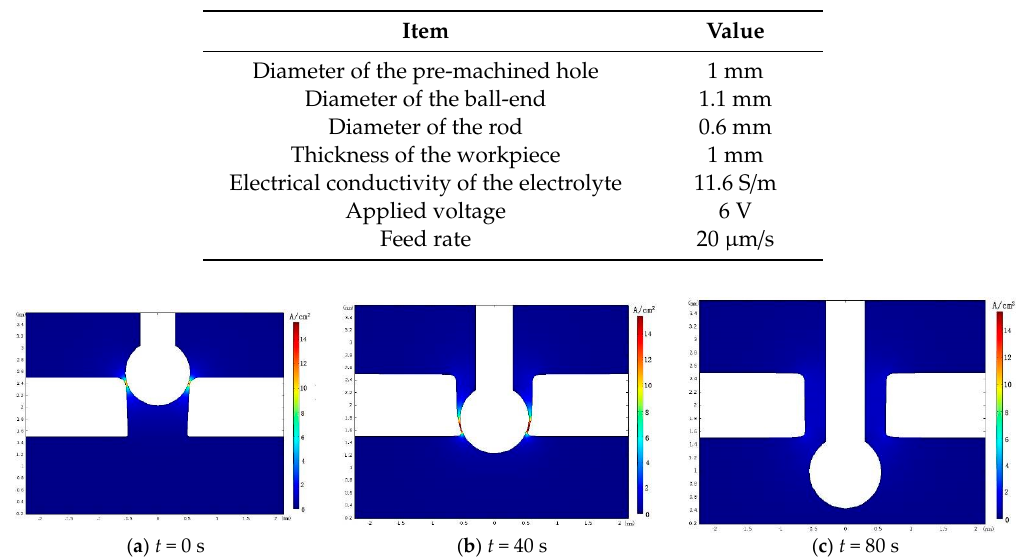
Figure 4. Schematic diagram of gap electric field in the process. Table 1. Parameters applied in the simulation